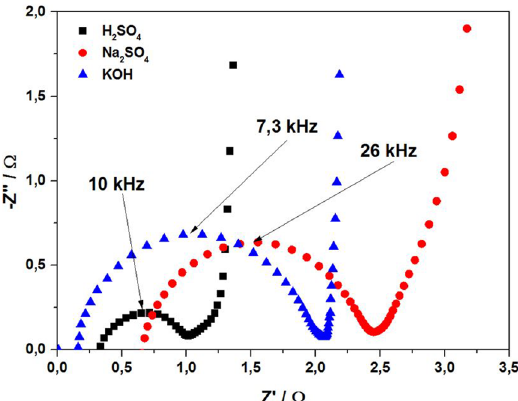
Figure 6. Nyquist plot corresponding to Ag@ACF performed at H SO , Na SO , and KOH. 2 4 2 4